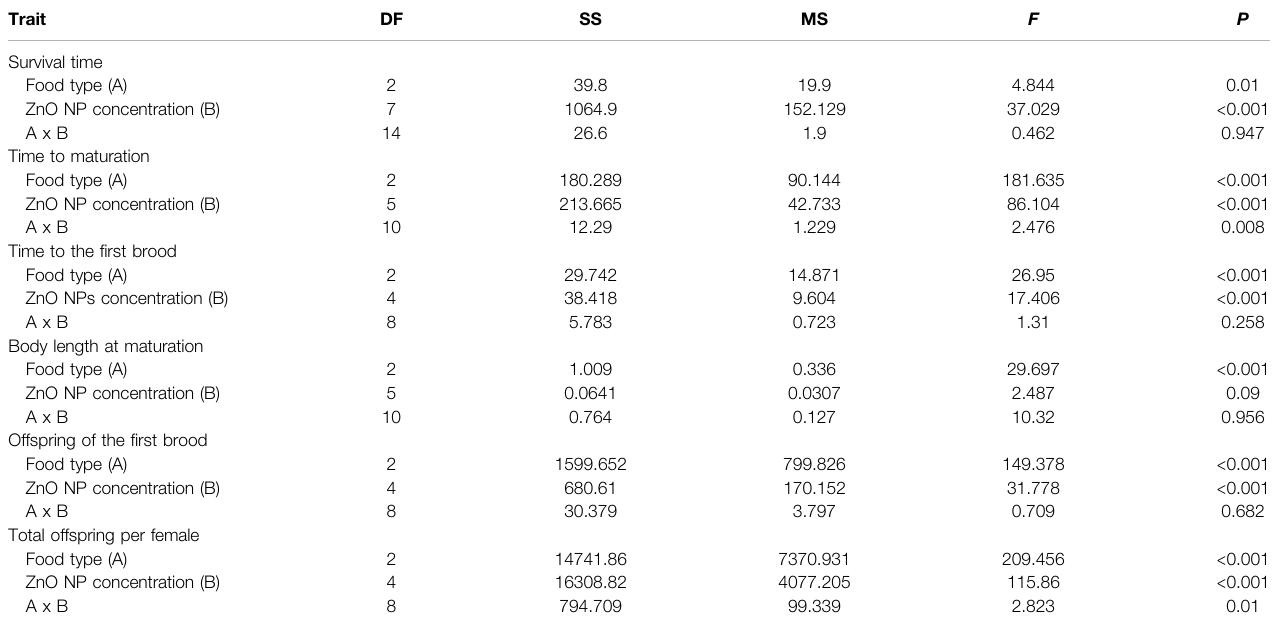
TABLE 1 | Two-way ANOVA on survival, development, and reproduction subjected to various ZnO NP levels and food types. Trait DF SS Survival time Food type